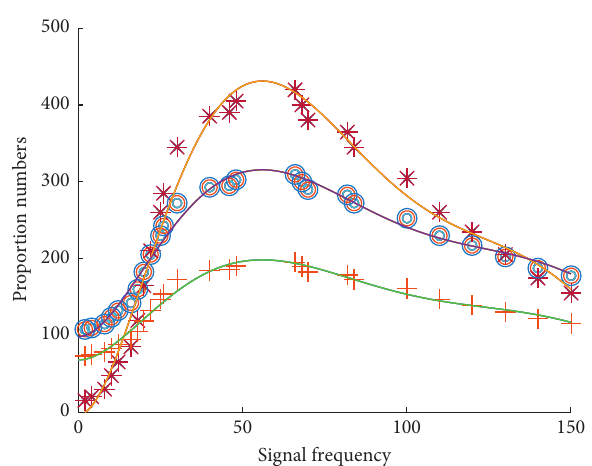
Figure 8: Fitting curve of each rhythm of the patient’s EEG de- composition after music therapy.